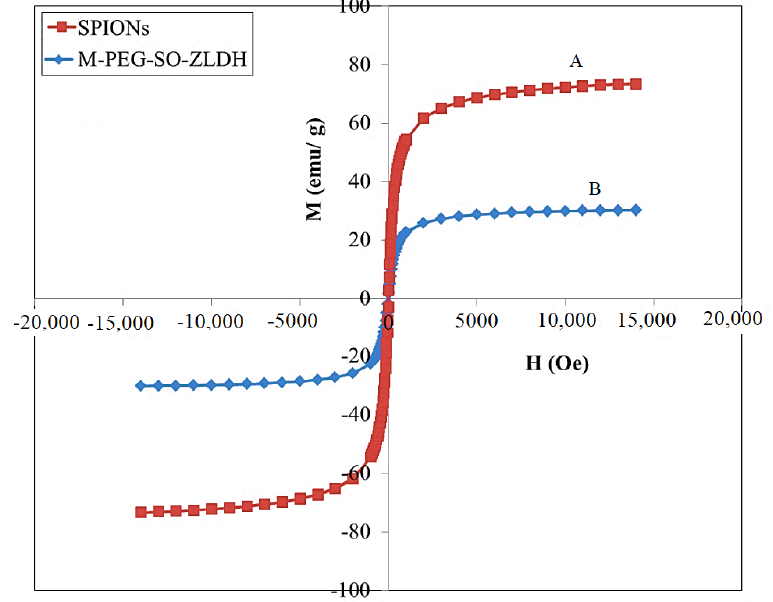
Magnetization curves of ( A ) superparamagnetic iron oxide nanoparticles and ( B ) drug-loaded magnetic nanoparticles (M-PEG–SO–ZLDH). Table 1. The magnetic property of superparamagnetic iron oxide nanoparticles (SPIONs) and their M-PEG–SO–ZLDH.